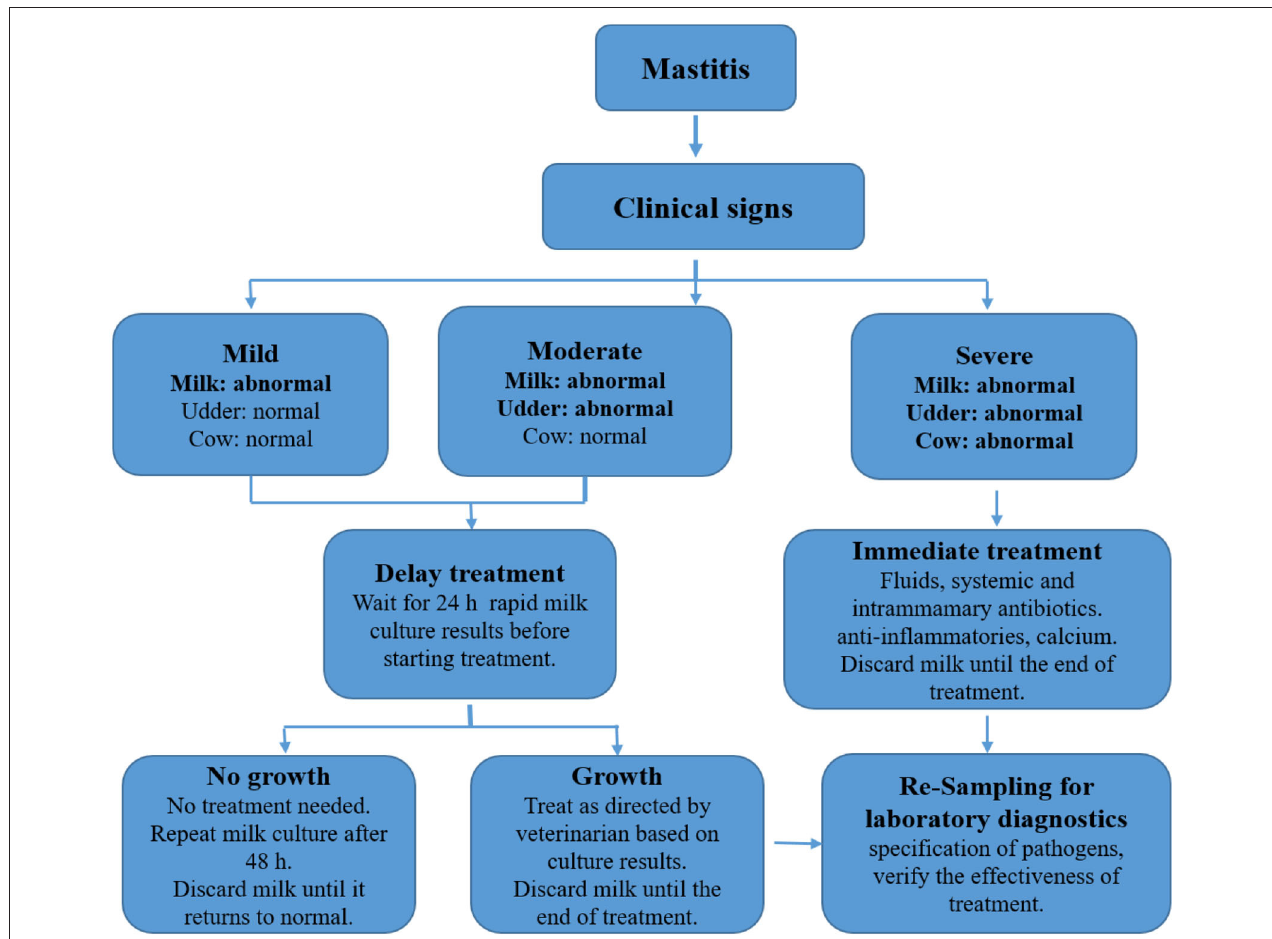
FIGURE 4 | Determination of severity and treatment of mastitis according to clinical symptoms. Source: Adapted from Bargren (56).